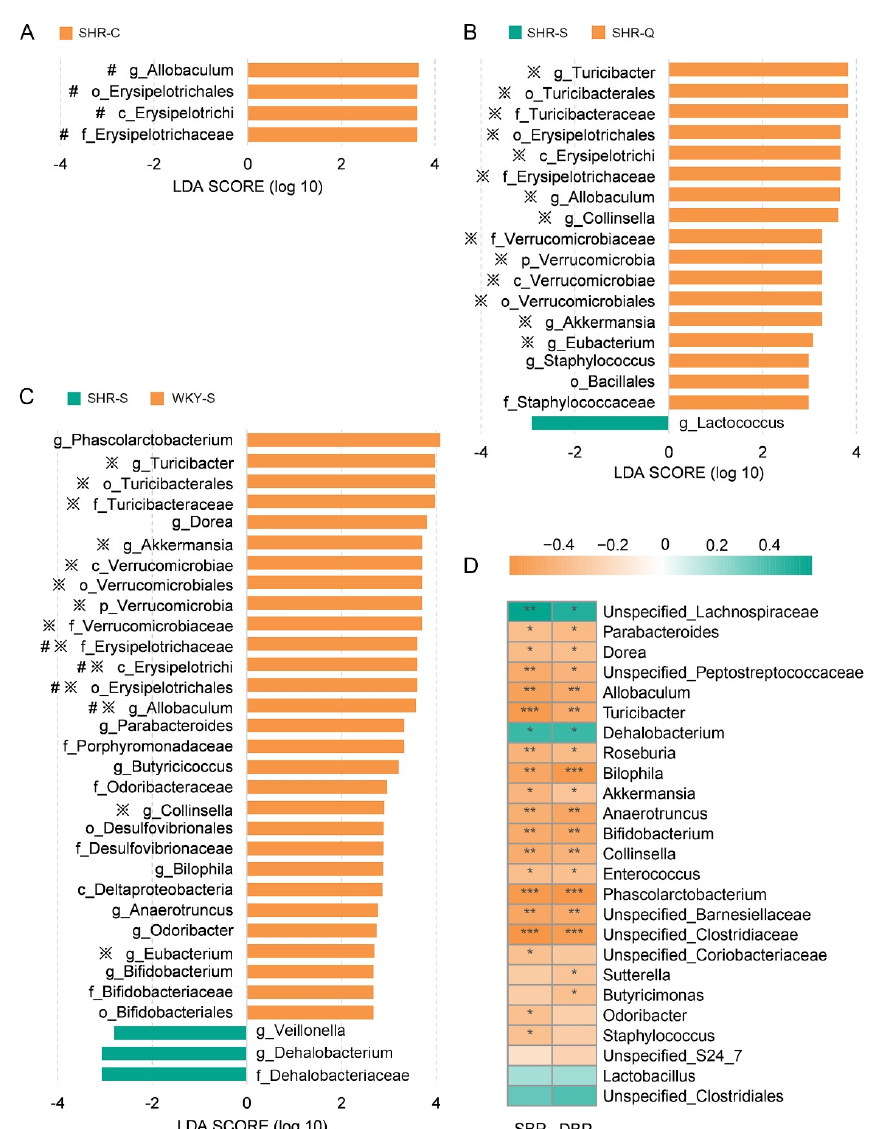
Figure 4. LEfSe analysis identifying taxonomic differences in fecal microbiotas. Histograms of LDA scores of microbiotas in ( A ) SHR–S vs SHR–C, ( B ) SHR–S vs SHR–Q, and ( C ) SHR–S vs WKY–S are shown with a cutoff value of LDA score above 2.0. Enriched taxa in SHR–S are indicated with a negative score (green), and taxa enriched in the SHR–C, SHR–Q, and WKY–S are characterized by a positive score (orange). The symbol “ ※ ” denotes the enriched taxon of both SHR–Q and WKY–S, and the symbol “#” denotes the enriched taxon of both SHR–C and WKY–S. ( D ) Heatmap of Spearman’s correlations between key microbiotas and blood pressure levels. Colors range from orange (negative correlation) to green (positive correlation). Significant correlations are marked by * p < 0.05, ** p < 0.01, *** p <